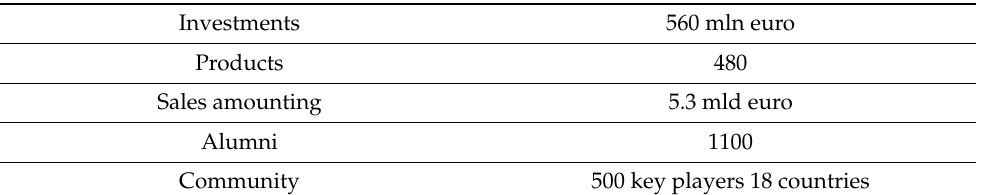
Table 3. EIT InnoEnergy results (source: own elaboration, based on: www.eit.europa.eu (accessed on 2 September